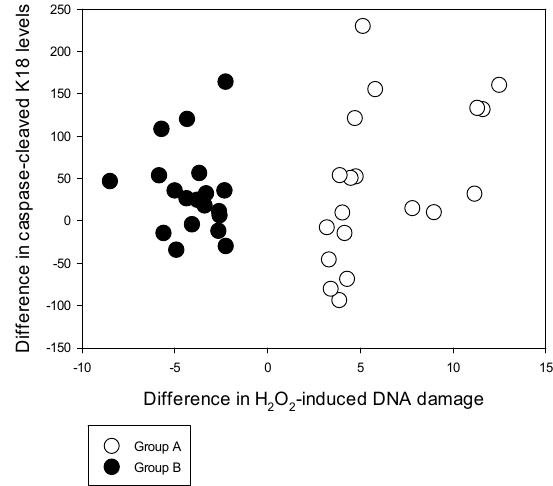
Table 4. Caspase ‐ cleaved K18 levels in plasma [units per litre mean (SD)] between subgroups A and B and between baseline and post ‐ supplementation time points.